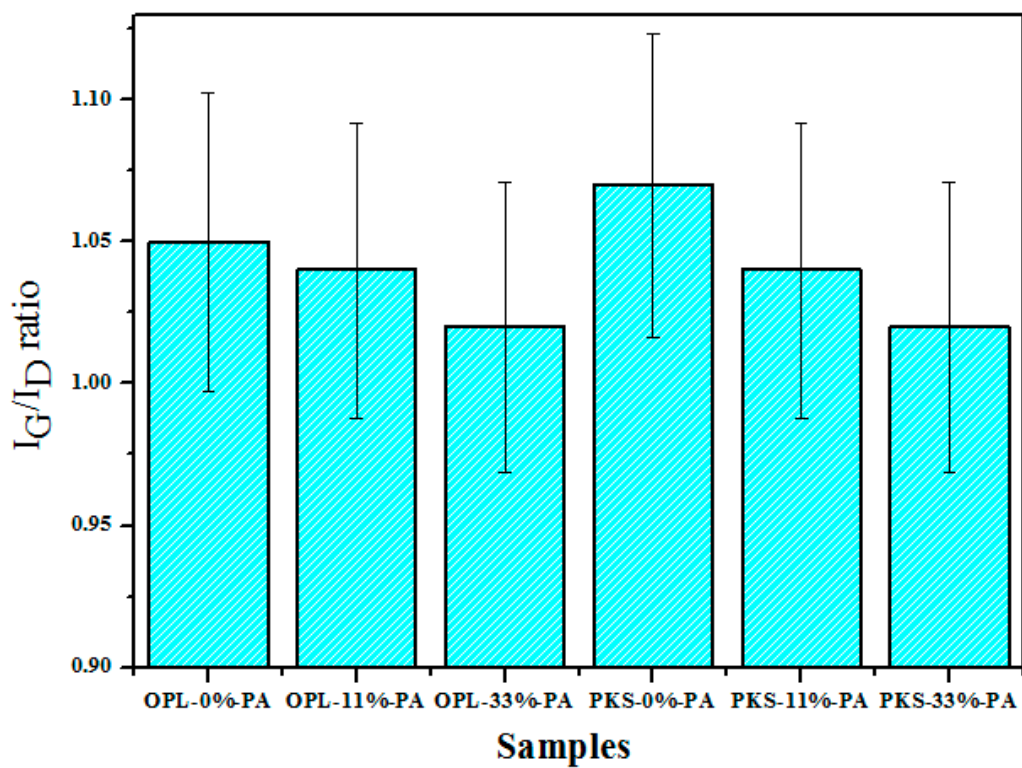
Figure 6. Plot of the ratio of the intensity of the Raman G and D peaks I G /I D of the as-prepared OPL- and PKS-derived activated carbons, produced at various concentrations of the activating reagent. (n = 3)